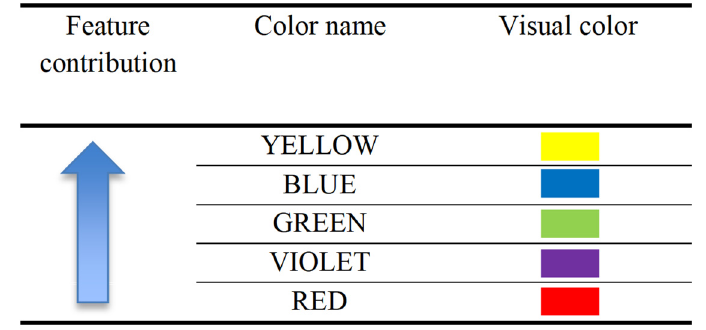
Figure 11. Feature contributing colors.